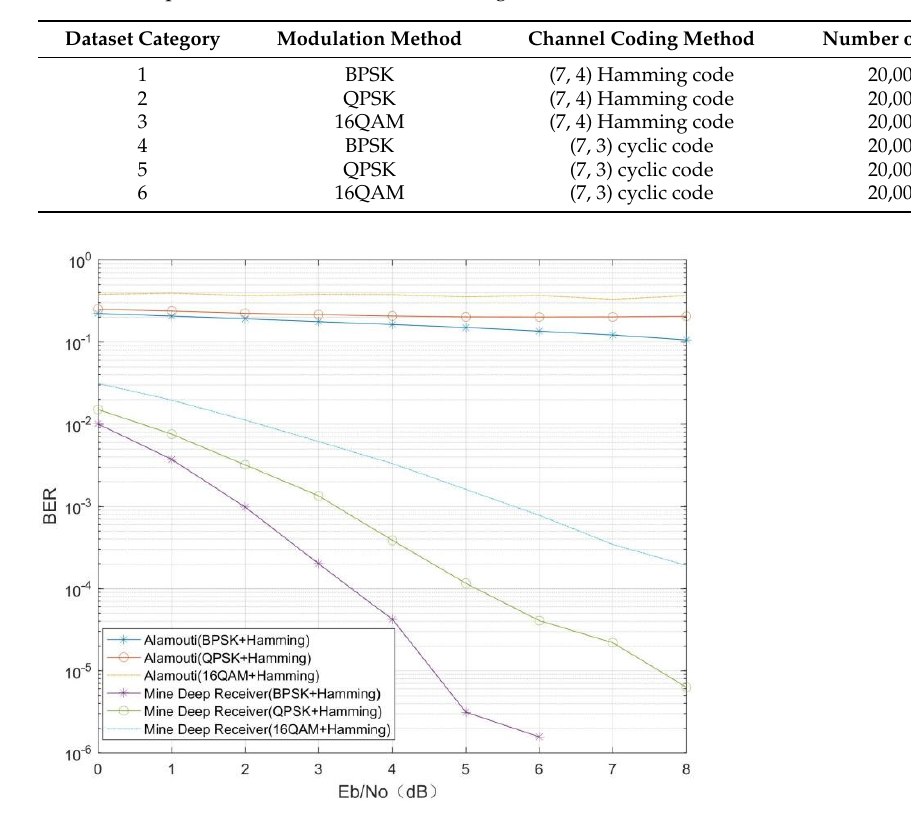
Figure 7. (7, 4) Hamming channel coding.